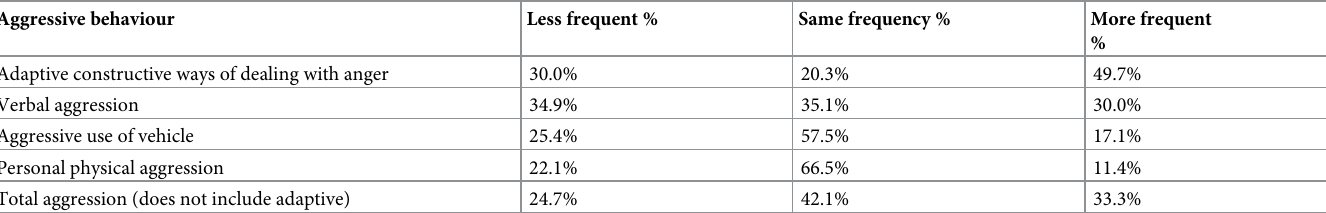
Table 3. Distribution of self-reported changes across different types of aggression (N =